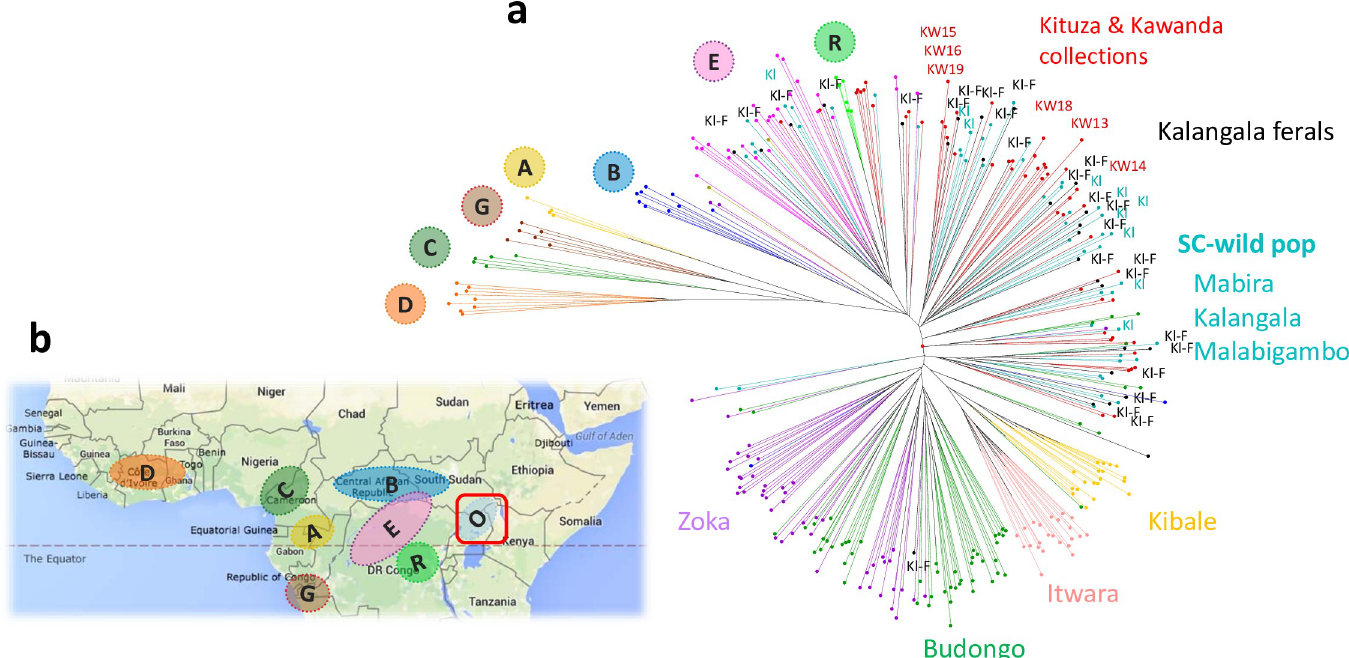
Fig 3. Ugandan C . canephora diversity relative to the species’ global diversity structure. a- Neighbour-joining of Ugandan wild C . canephora material together with feral accessions from Kalangala islands (noted “Kl-F” in black) and cultivated material maintained in Kituza and Kawanda collections (in red). The six elite clones, KW13, KW14, KW15, KW16, KW18 and KW19 are indicated. Wild material was collected from Zoka, Budongo, Kibale, Itwara, Malabigambo, Mabira and Kalangala islands (Kl). The colours of branches of wild material correspond to the five clusters from the population structure analysis presented in Fig 2. Individuals representative of other genetic groups (A, B, C, D, E, R) from the whole species diversity are also presented for reference . b - Eight divergent genetic groups of C . canephora and their geographical distribution (adapted from [23]).